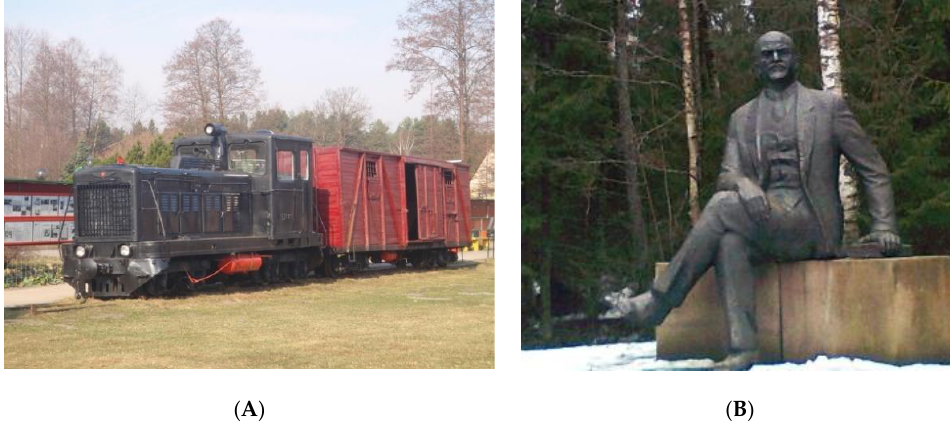
Figure 8. Train used for mass deportation in 1941. Available online: Figure 8. ( A ) Train used for mass deportation in 1941. Available online: https://tinyurl.com/ 2d73f9he (accessed on 22 March 2022); ( B ) Statue in The Gr¯utas Park. Available online: https: //tinyurl.com/2d73f9he (accessed on 22 March 2022). The Paneriai memorial (Figure 9A,B) is the darkest dark tourism object in Lithuania.